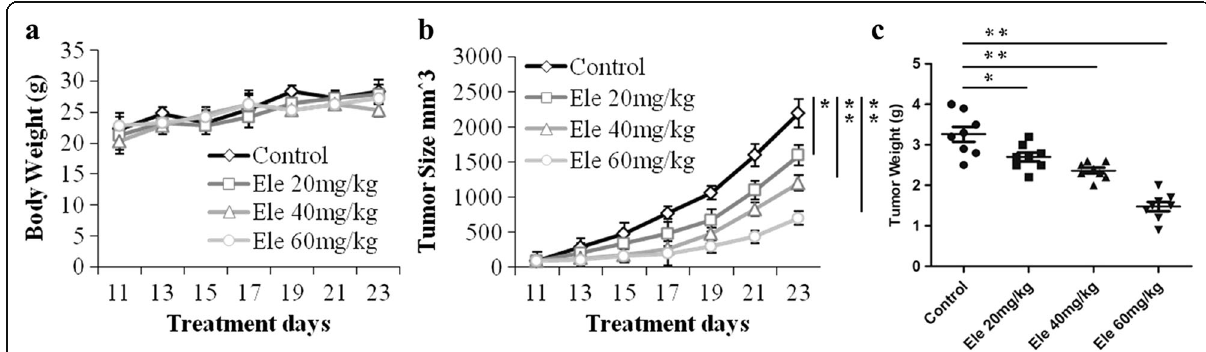
Fig. 1 Effects of elemene on body weight ( a ), tumor size ( b ) and tumor weight ( c ). * P < 0.05, ** P < 0.01 vs control group. Ele: